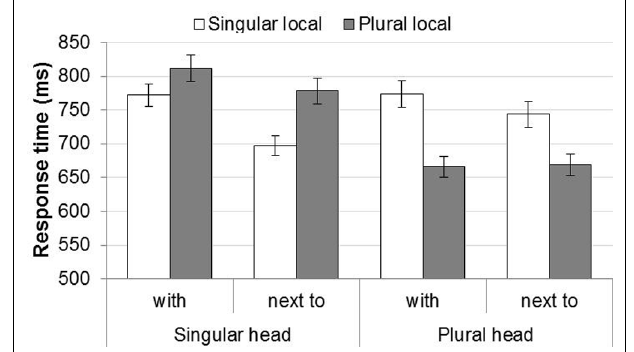
FIGURE 3 | Response times in Experiment 2. Error bars show the SE of the mean across participants, for illustrative purposes.